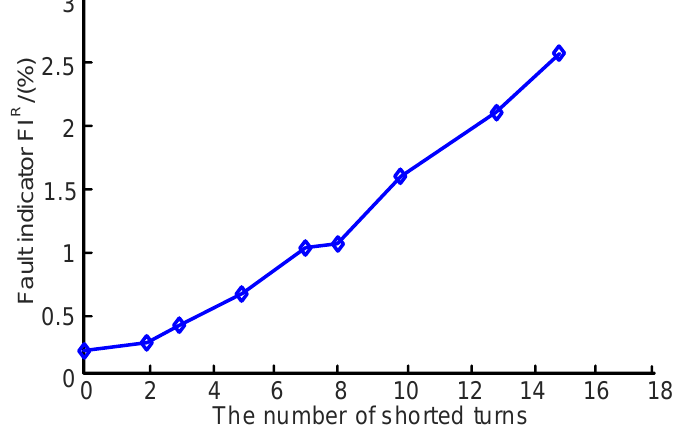
Figure 8. FI R under different numbers of the shorted turns.